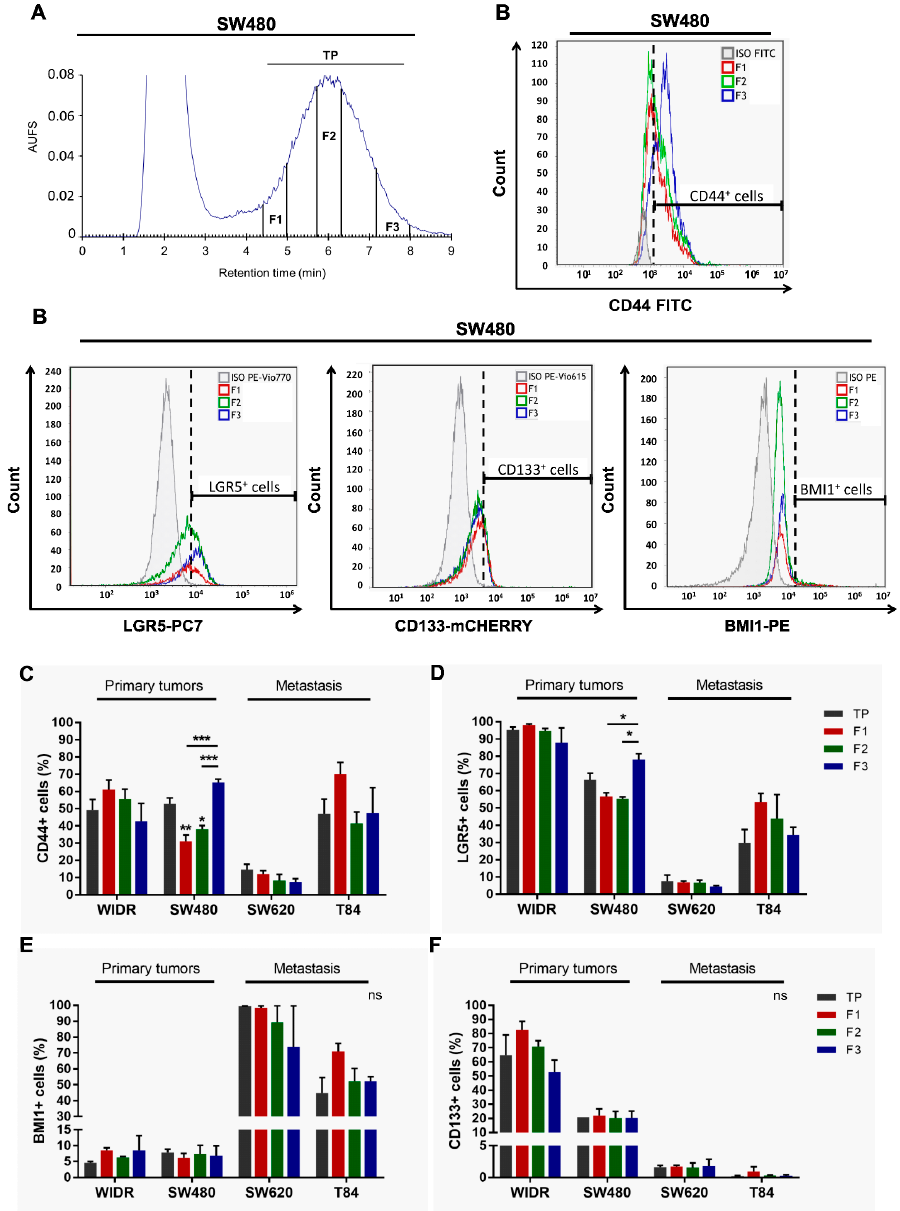
Figure 1. Phenotypic characterization of SdFFF sorted cell subpopulations from CRC cell lines. ( A ) Fractogram of the SW480 cell line obtained by SdFFF with the sorted cell subpopulations: total peak control (TP), F1, F2, and F3. AUFS: absorbance units full scale. ( B ) The expression level of CSC markers, CD44, LGR5, BMI1, and CD133, was assessed by flow cytometry and plotted as histograms for the SW480 cell line. Graphs show one representative biological replicate (n = 3). ( C – F ) Quantification of CD44 ( C ), LGR5 ( D ), BMI1 ( E ), and CD133 ( F ) positive cells was summarized in the bar plot for all cell lines. All these results are represented as means ± SEM and statistical differences with ns means a non-significant result both between the sorted cell subpopulations and between a sorted subpopulation and the control, * p -value < 0.05, ** p -value < 0.01, *** p -value < 0.001, and * alone for significant results compared to TP using one-way ANOVA